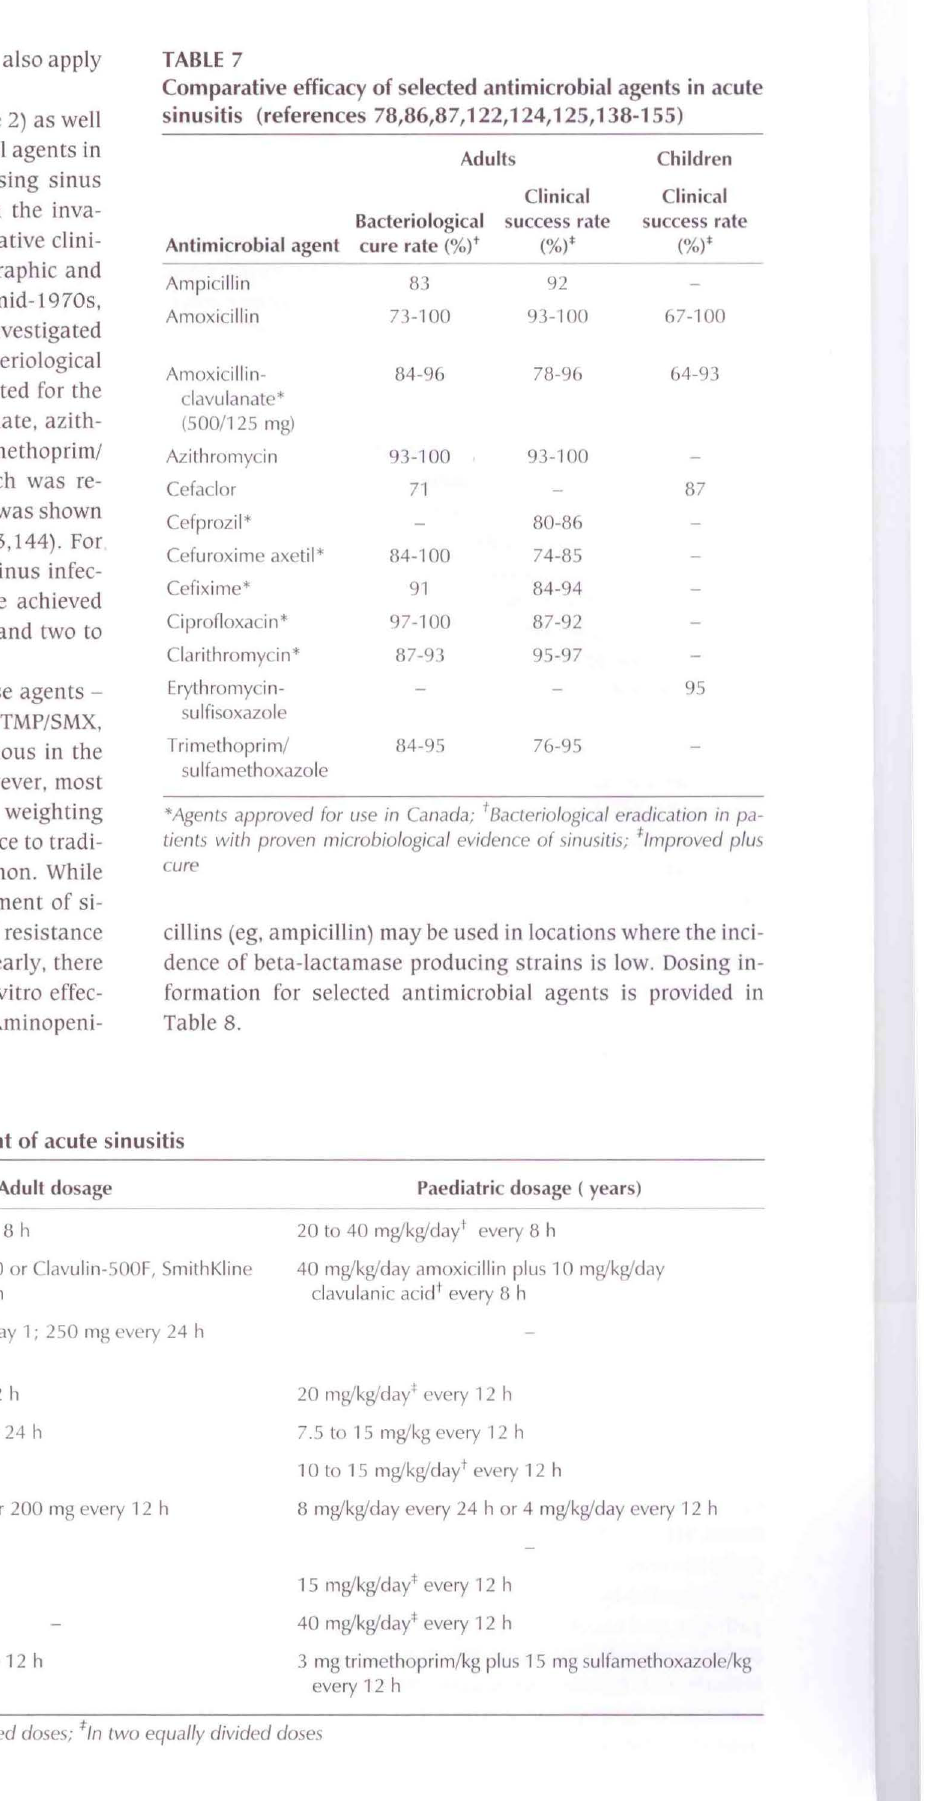
Sinusitis clinical practice guidelines